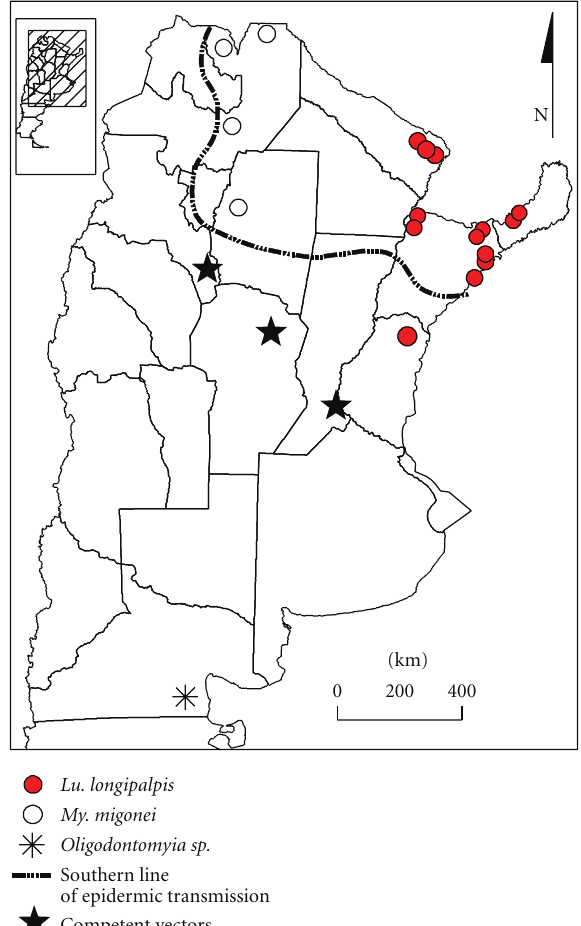
Figure 2: Lutzomyia longipalpis spread (black circles) and human cases associated with My. migonei as its putative vector (white circles). Southernmost record of Phlebotominae and records of competent